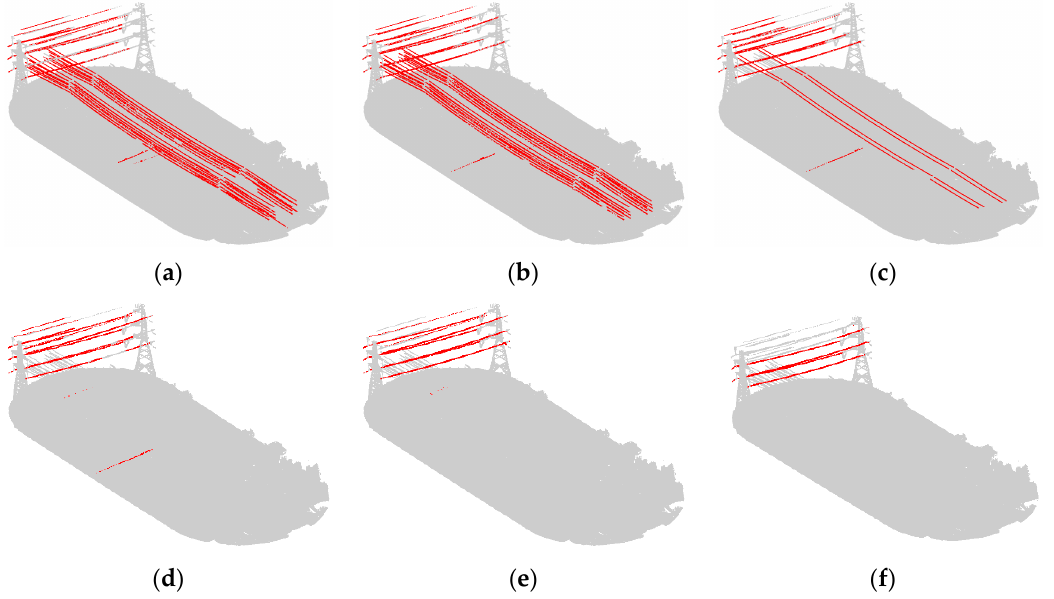
Figure 7. Power line classification visualization results under different scales: ( a ) 2.2 m; ( b ) 3.2 m; ( c )